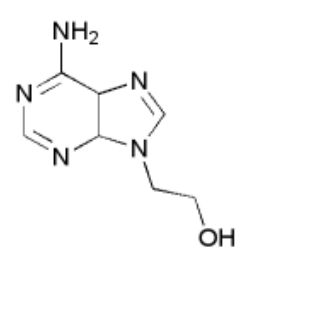
Figure 1. Structure of